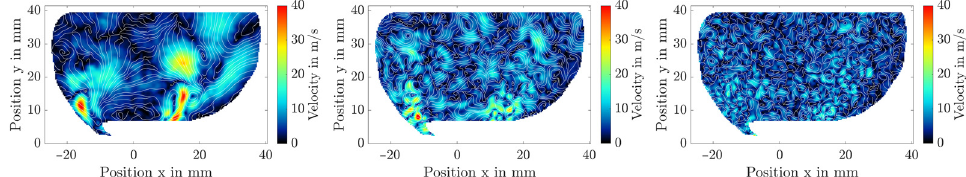
Figure 20. POD quadruple decomposition of the PIV results at 4 mm and 39.6 kg/h showing the cumulated dominant ( left ), coherent ( middle ) and turbulent ( right ) structures.